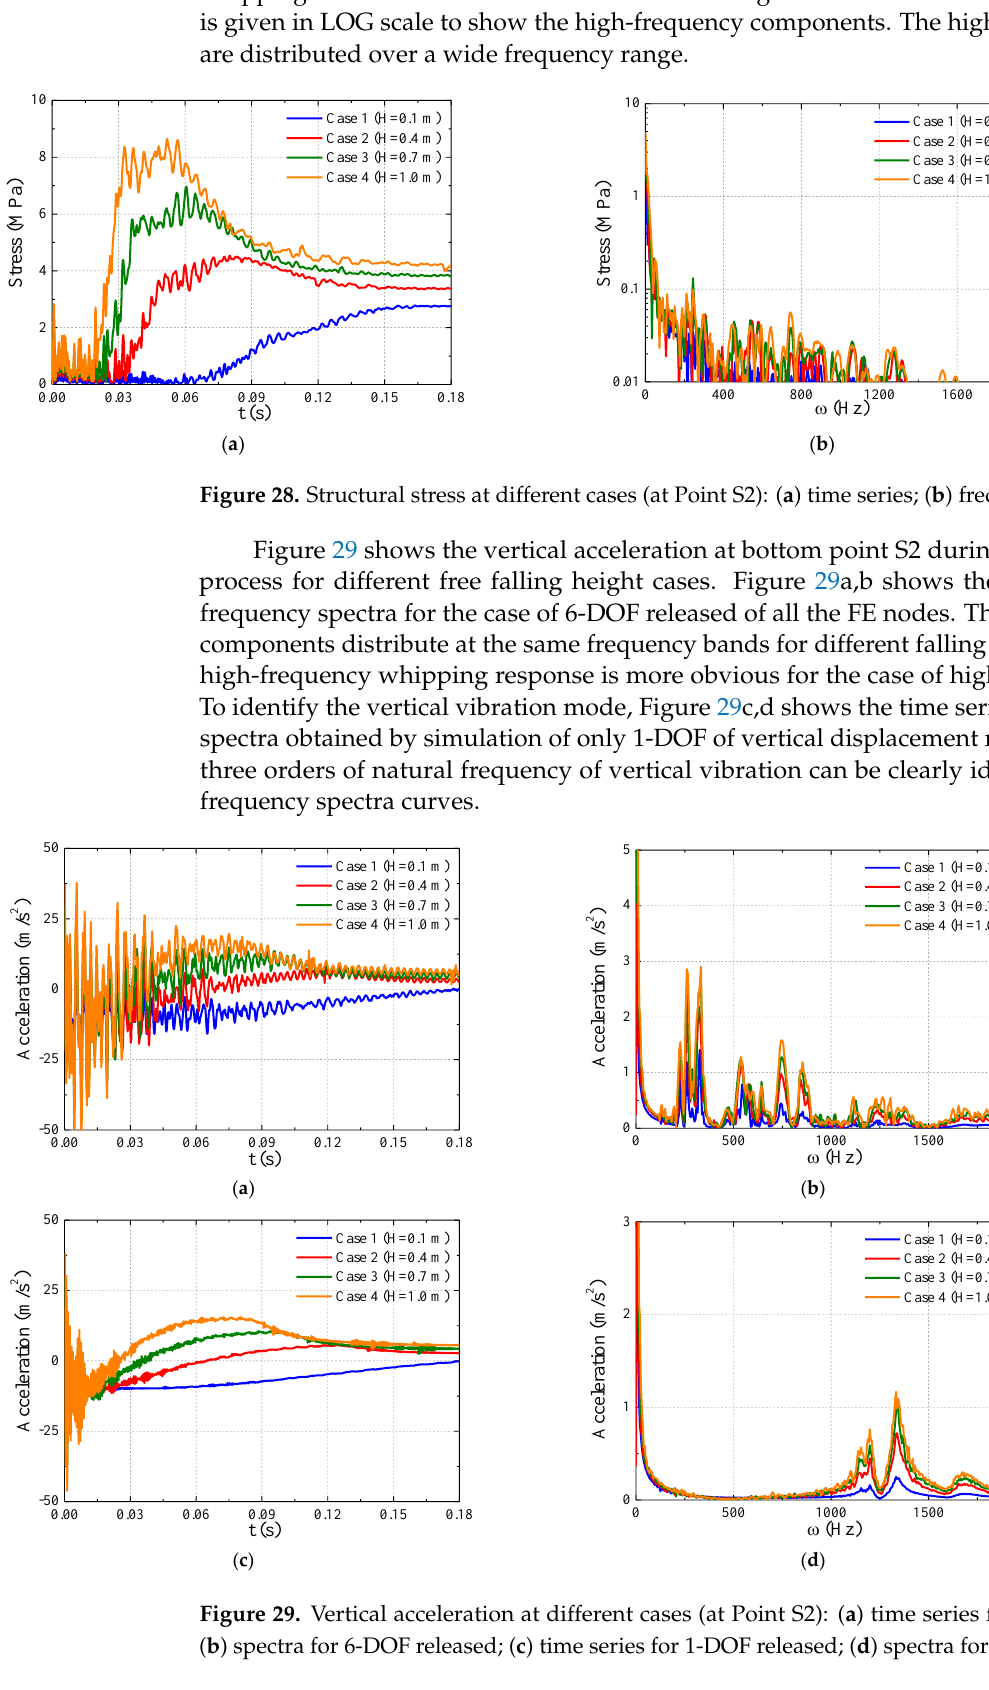
frequency whipping concentrates around the crest of the stress curve. The high-frequency whipping is weak for Case 1 due to weak slamming effects. The ordinate of stress spectra is given in LOG scale to show the high-frequency components. The high-frequency loads are distributed over a wide frequency range.